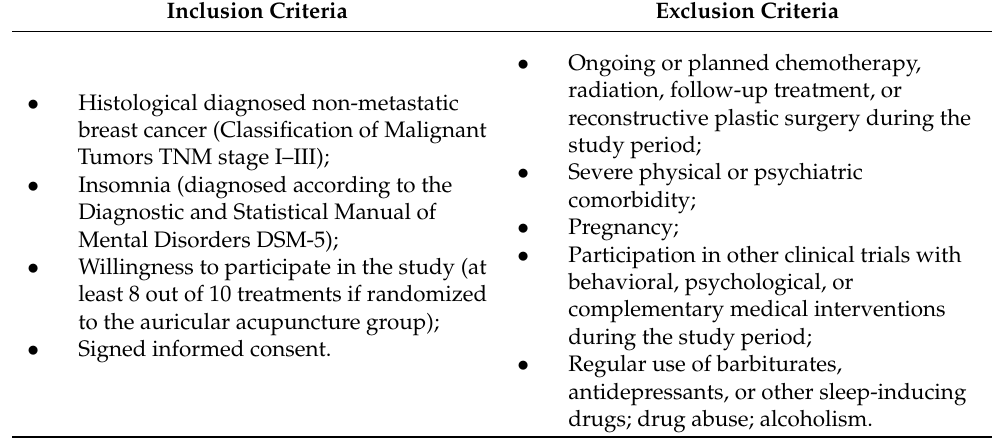
Table 1. Inclusion and exclusion